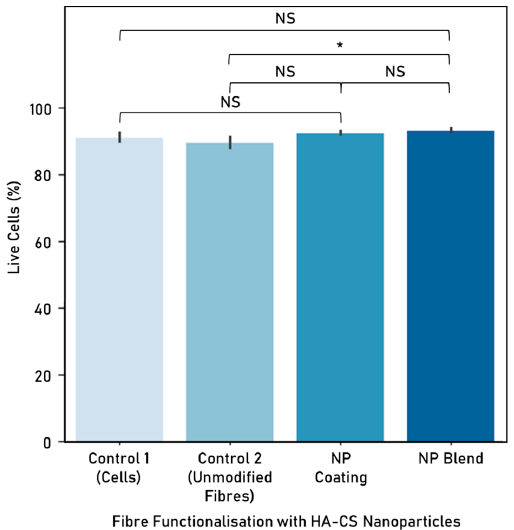
Figure 13. Cell viability (%) following 72 h co-culture with hyaluronic acid-chitosan nanoparticles (mean ± standard deviation). HA-CS nanoparticle concentration: 1 × 10 − 2 mg/mL. Cell seeding number: 300,000 cells, 6-well plate used, controls: cells-only (control 1) and unmodified fibres (control 2). Fibres were electrospun from a polycaprolactone-gelatine (70:30 PCL:Ge solution ratio) polymer, at 8% w / v initial PCL or Ge in solvent. Electrospinning parameters—time: 300 s, solvent: TEF, voltage: 10 kV, distance between nozzle and collector: 15 cm. Significant (*) and nonsignificant (NS) differences between samples are shown (ANOVA/Tukey, p < 0.05; n = 3).